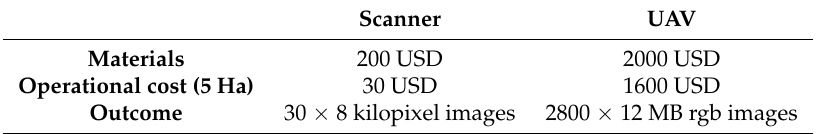
Table 1. Estimated costs of materials and operation of the proposed Scanner and UAV image acquisition.